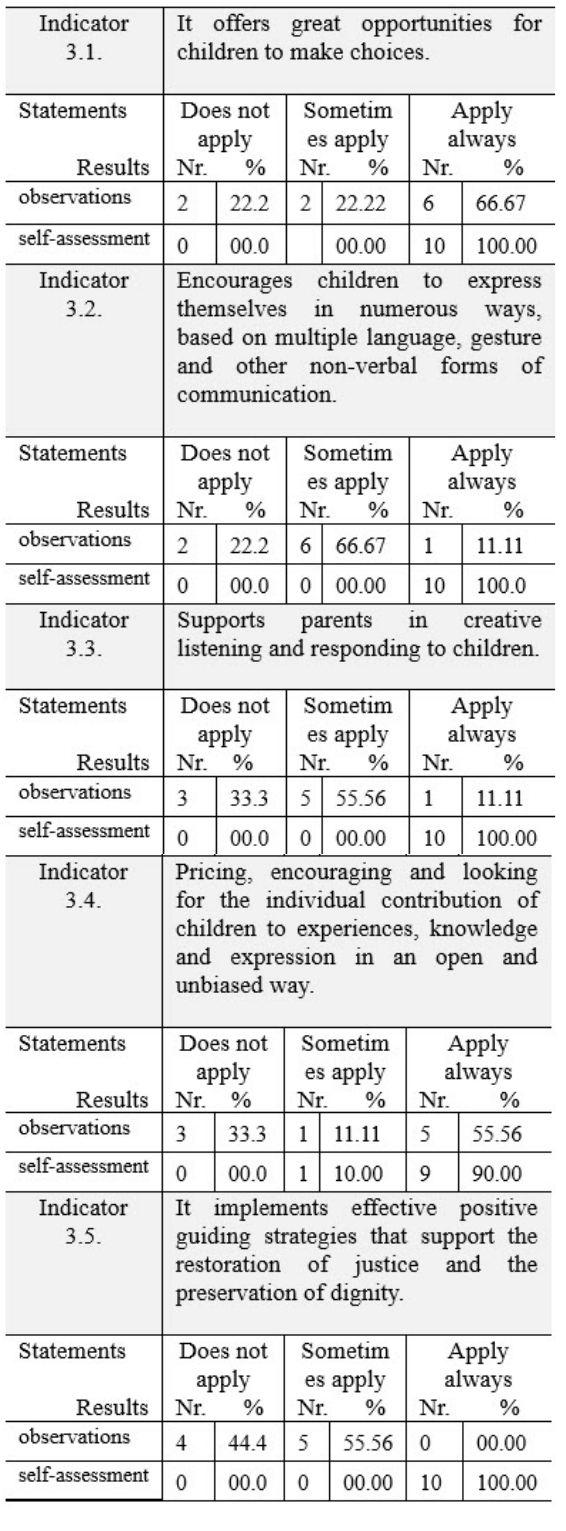
Table 12. Principle 3: Promoting the sense of individuality, opinion and decisions of each child, motivating democratic values and practices.